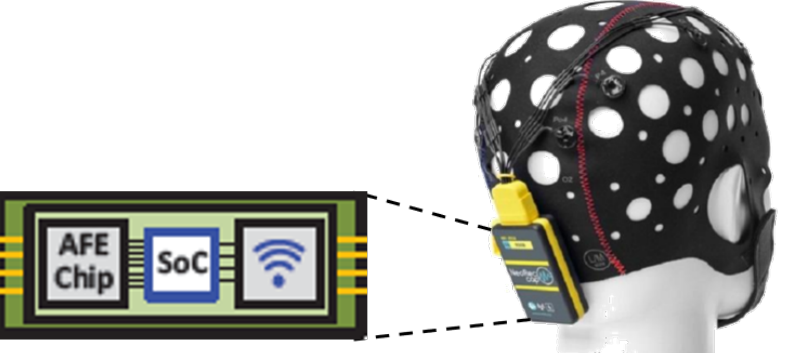
Figure 4. The main application domain of BCI